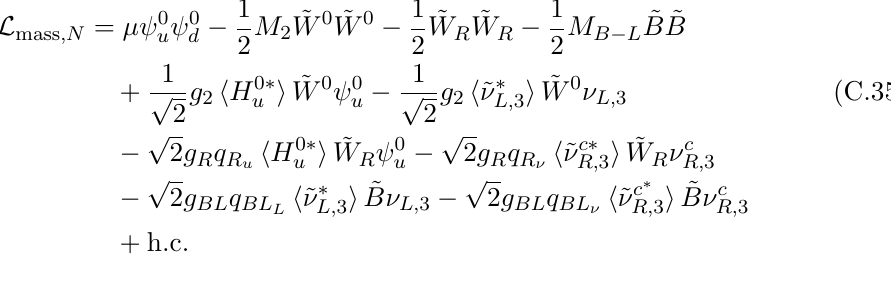
~ C (cid:0) . Here, the 1 2